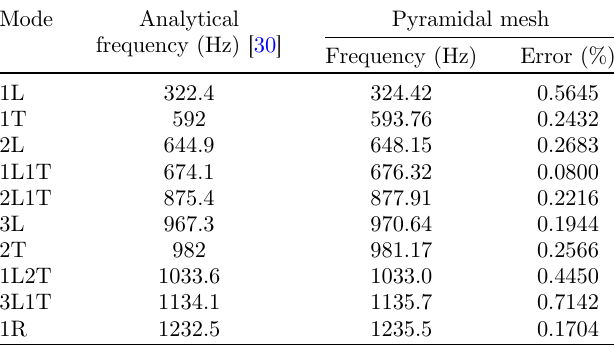
Table 1. Resonance frequencies of the fully closed cylindrical chamber via analytical method [30] and numerical